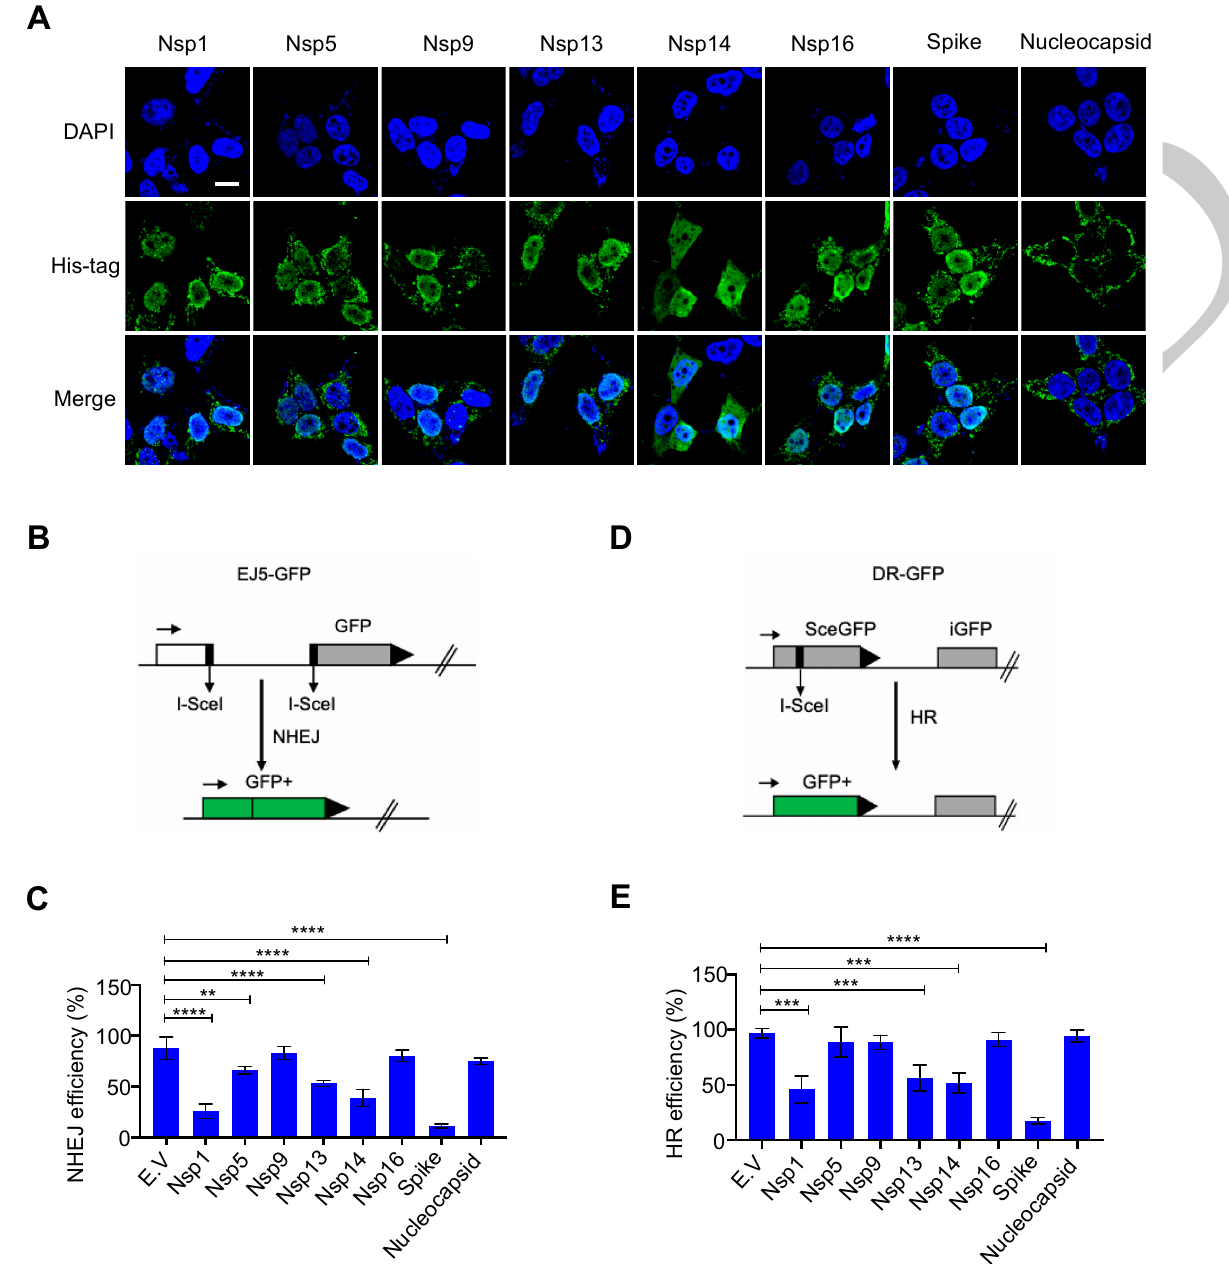
Figure 1. Effect of severe acute respiratory syndrome coronavirus 2 (SARS–CoV–2) nuclear-localized proteins on DNA damage repair. ( A ) Subcellular distribution of the SARS–CoV–2 proteins. Immunofluorescence was performed at 24 h after transfection of the plasmid expressing the viral proteins into HEK293T cells. Scale bar: 10 µ m. ( B ) Schematic of the EJ5-GFP reporter used to monitor non-homologous end joining (NHEJ). ( C ) Effect of empty vector (E.V) and SARS–CoV–2 proteins on NHEJ DNA repair. The values represent the mean ± standard deviation (SD) from three independent experiments (see representative FACS plots in Figure S2A). ( D ) Schematic of the DR-GFP reporter used to monitor homologous recombination (HR). ( E ) Effect of E.V and SARS–CoV–2 proteins on HR DNA repair. The values represent the mean ± SD from three independent experiments (see representative FACS plots in Figure S2B). The values represent the mean ± SD, n = 3. Statistical significance was deter- mined using one-way analysis of variance (ANOVA) in ( C ) and ( E ). ** p < 0.01, *** p < 0.001, **** p < 0.0001.